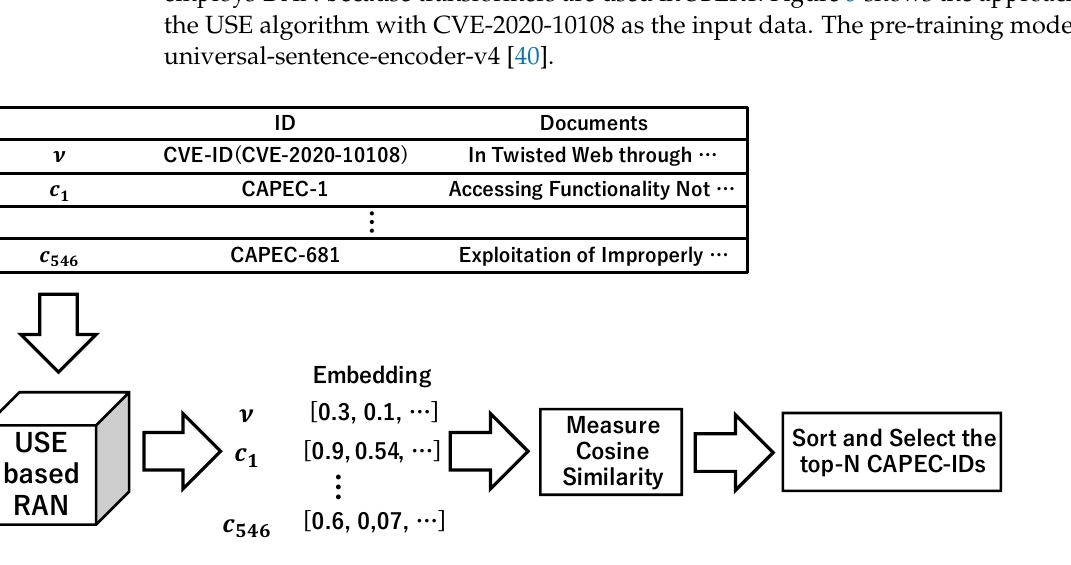
Figure 4. Overview of the tracing based on the TF-IDF algorithm.